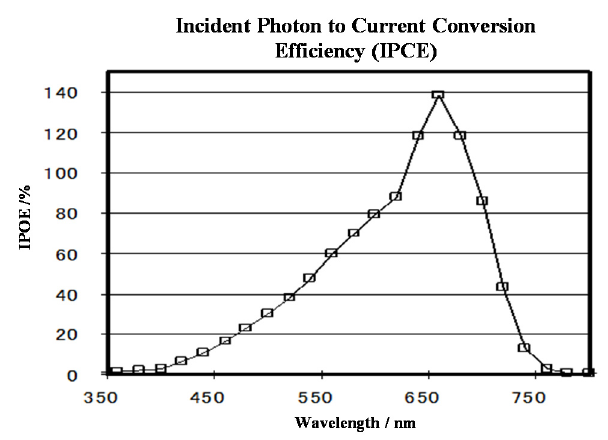
Figure 14. IPCE curve measured for a graded bandgap solar cell structure. Note the 140% IPCE value around 650 nm, even with severe losses at both blue- and red-ends of the